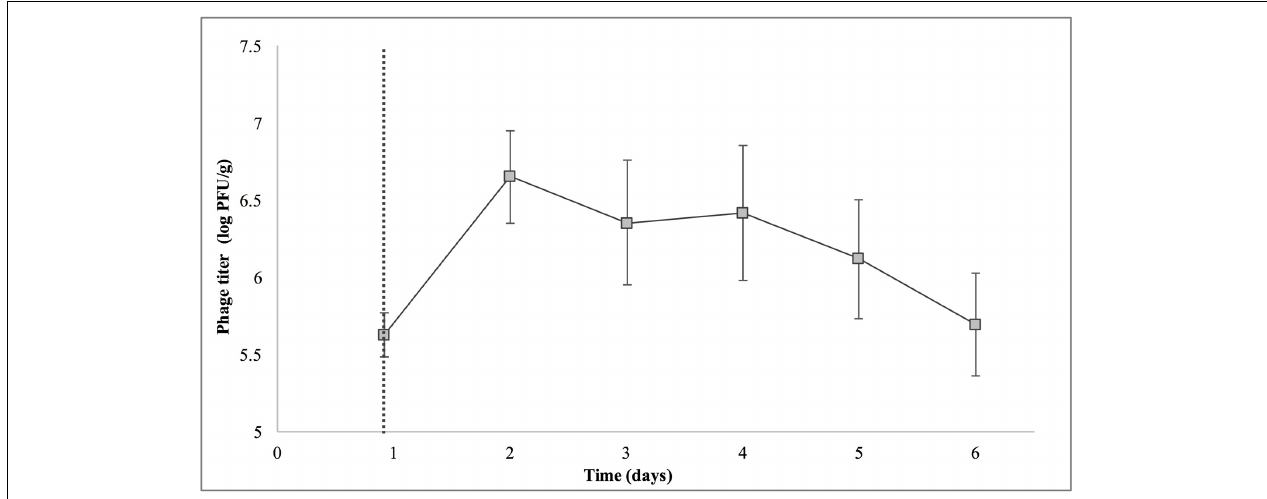
FIGURE 10 | Titer of phage SI1 during control of S. Enteritidis on alfalfa sprouts. Dotted line indicates the phage treatment at 22 h after artificial contamination of the seeds. Data shown are the mean of three replicates ±